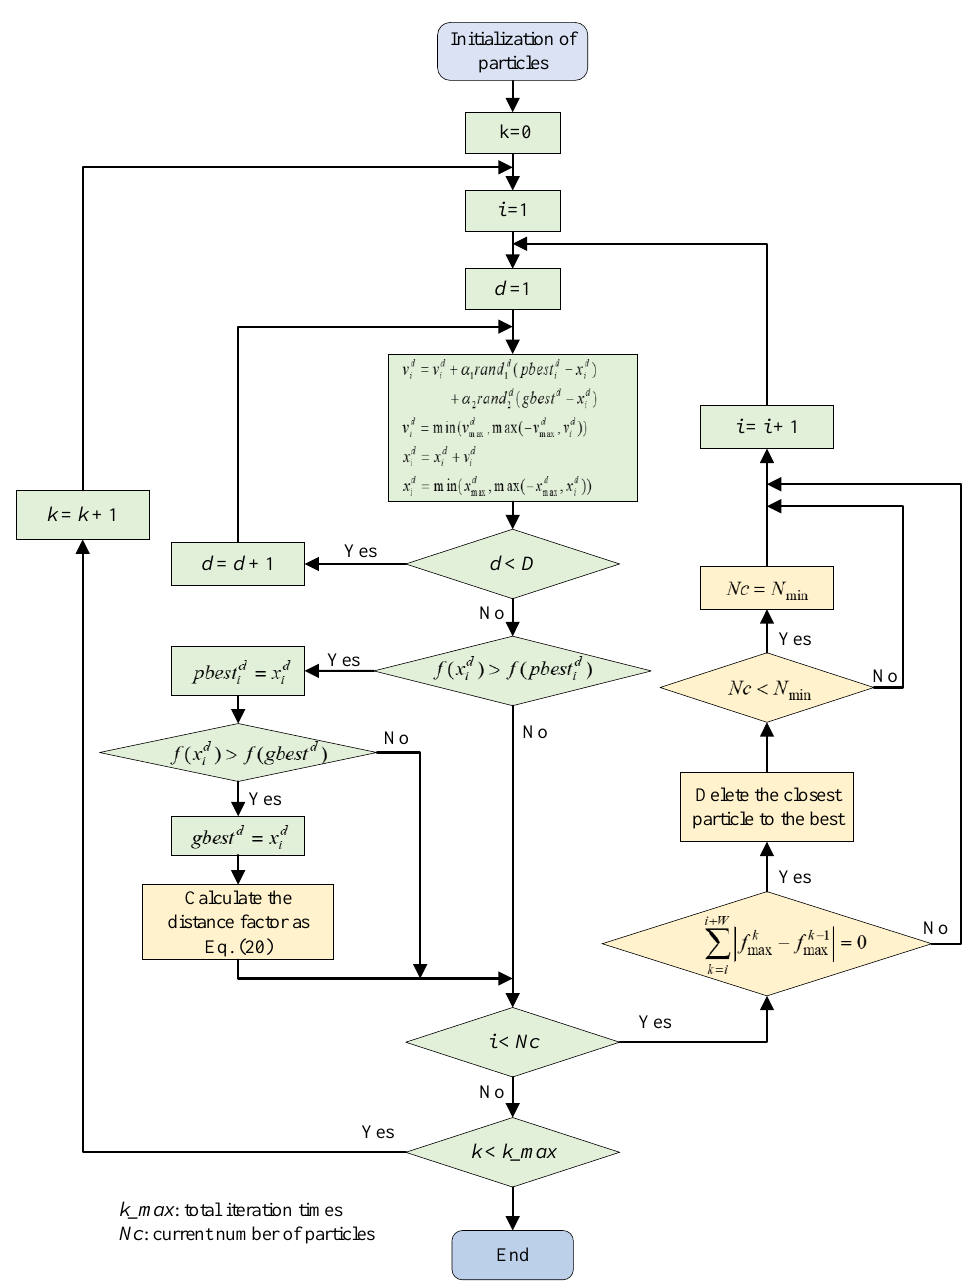
Figure 4. Flow chart of the adaptive particle swarm optimization (APSO) algorithm.